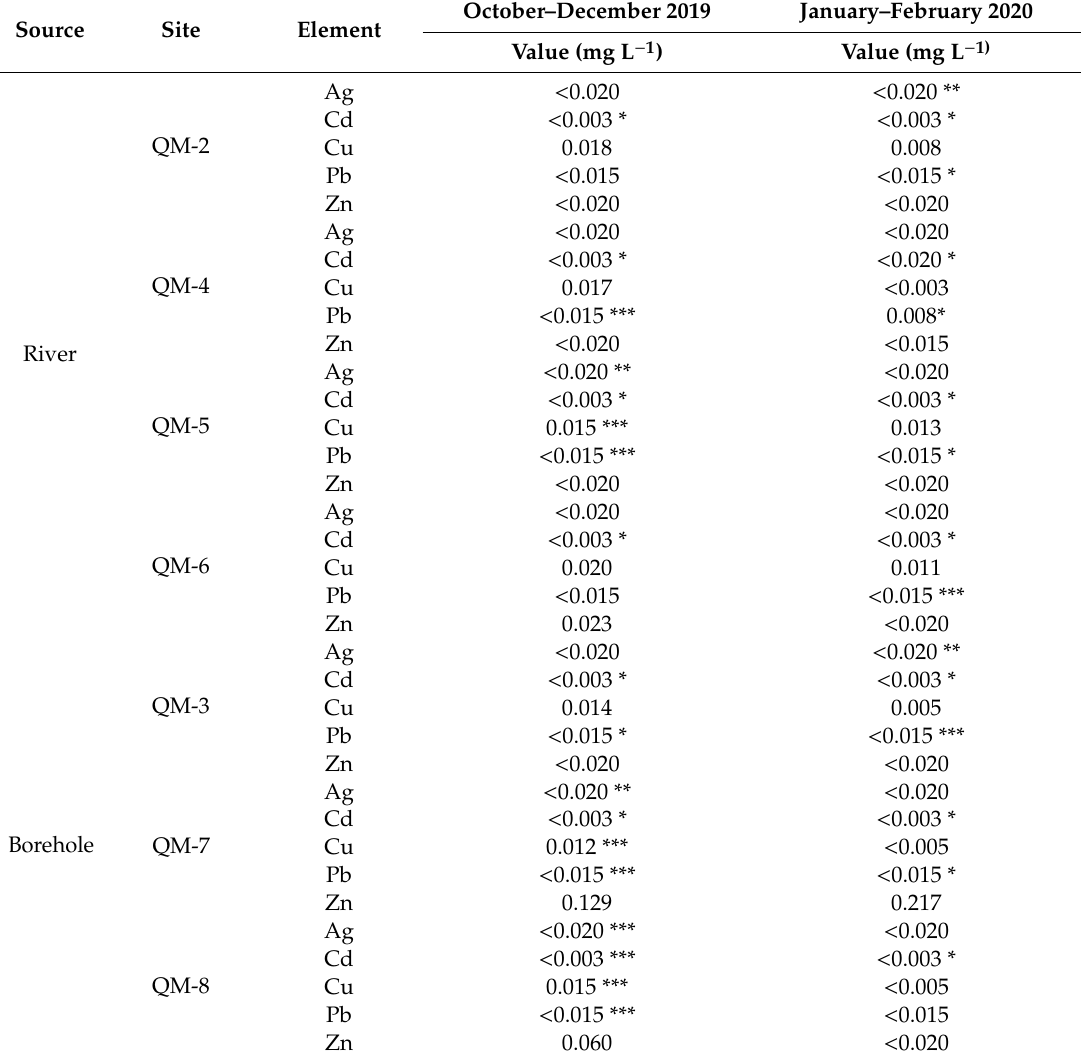
Table 4. Chemical analysis of heavy metals in water